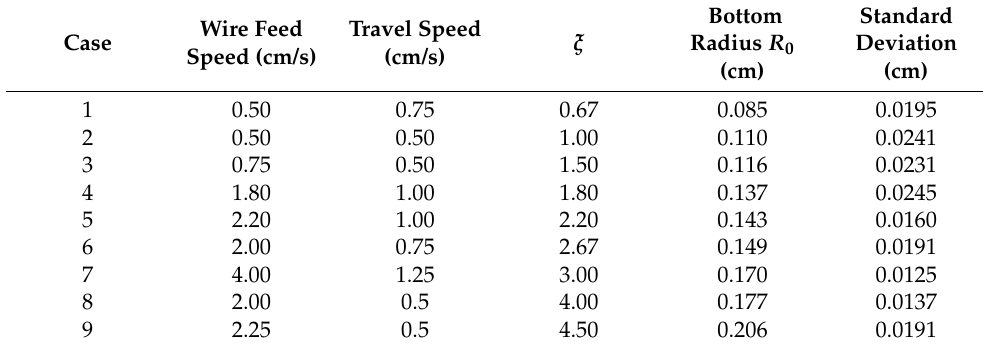
Table 3. Numerical cases for calibrating the bottom